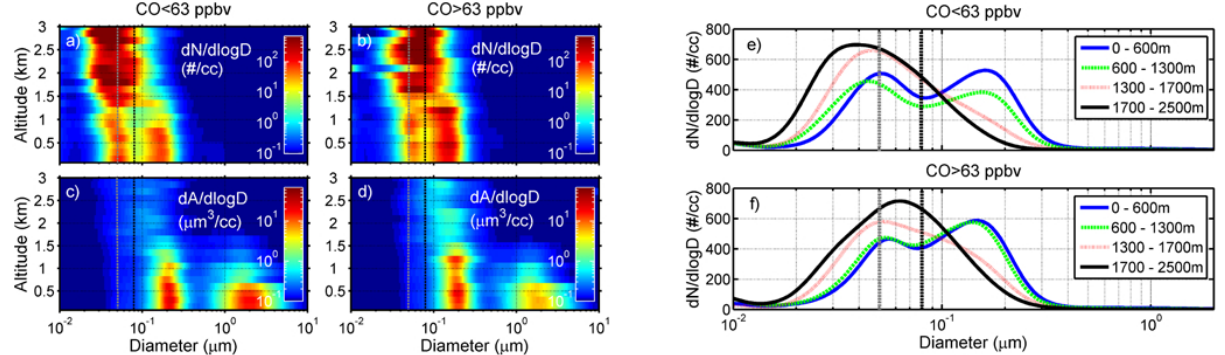
Fig. 10. (a–d) PASE mission averaged vertical profiles of size distributions color coded by number (upper) and area (lower) for low CO (left) and high CO (right) data. (e, f) Mean size distributions for indicated altitude ranges stratified by CO. The black vertical line indicates the Hoppel minimum, the representative diameter above which particles are active CCN in typical clouds, while the vertical gray line approximates the start of the minimum, showing the smallest sizes at which activation